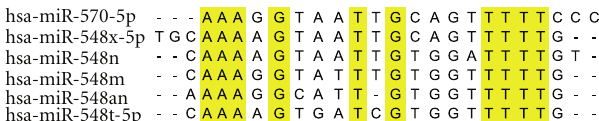
Figure 2: An example of nucleotide divergence patterns of mature miRNAs. Substitution (transition/transversion) and inser- tion/deletion can be detected among di ff erent mature miRNAs. Simultaneously, their seed sequences can be found shifting events because di ff erent 5 (cid:2) ends.